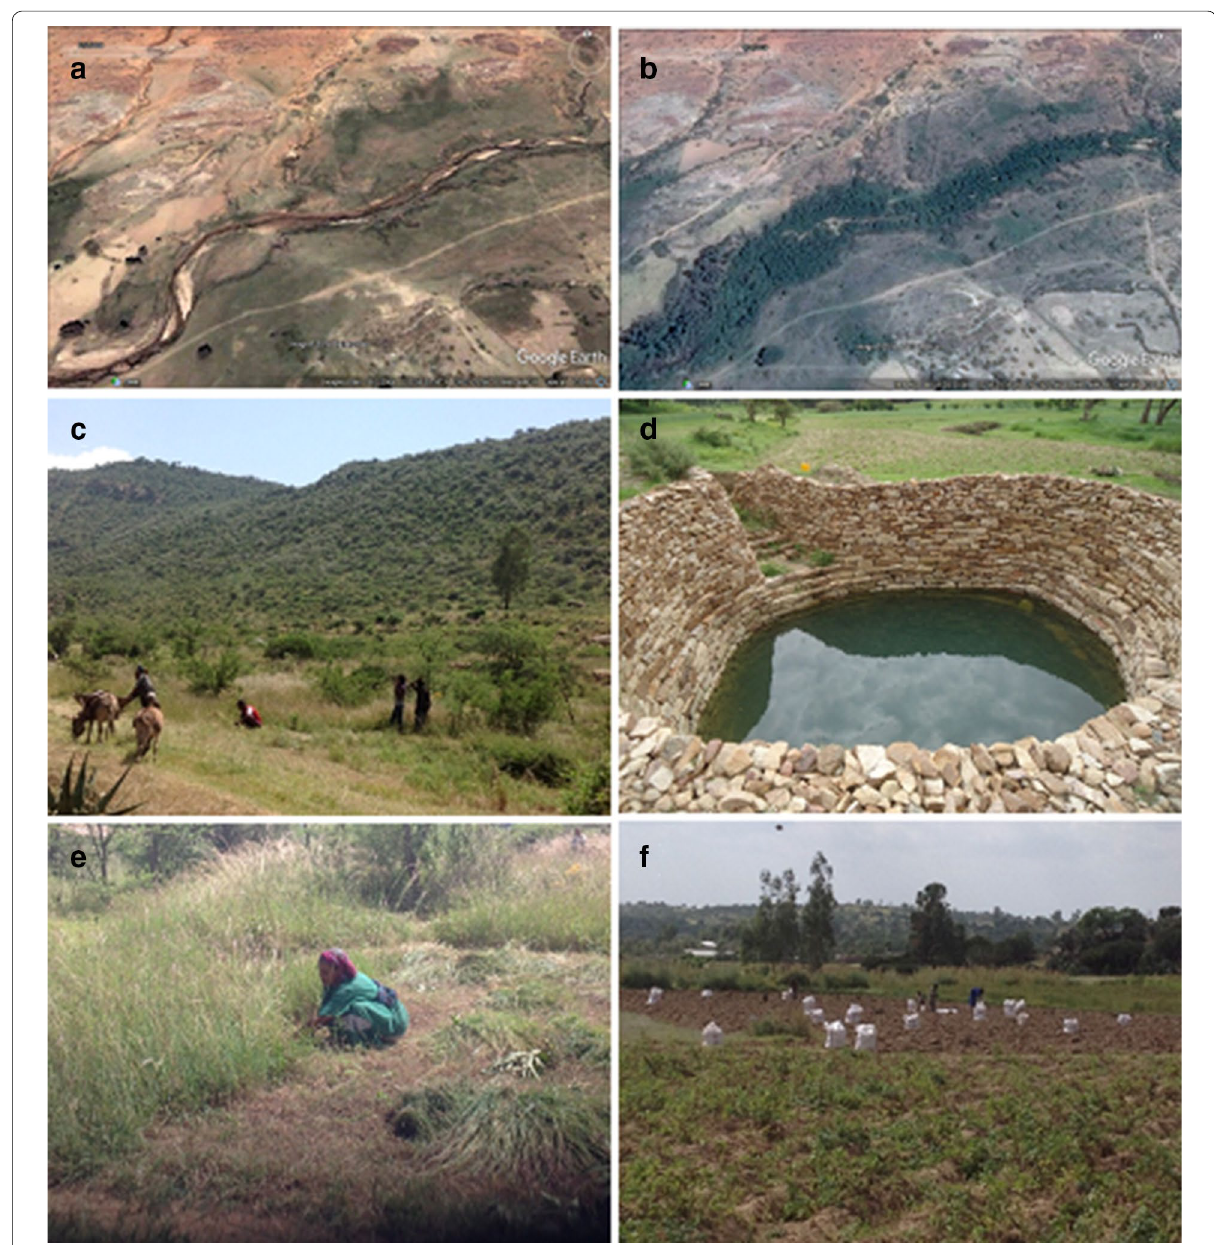
Fig. 5 Rehabilitation of degraded landscape and its benefit to local farmers. a Heavy gully observed in 2006 from google Earth (Kilte Awulaelo district, village Abraha Atsibaha); b restored gulley in 2016 photo from google Earth (Kilte Awulaelo district, village Abraha Atsibaha); c conserved hillside (Kilte Awulaelo district, village Abraha Atsibaha, photo: researcher); d ground water harvesting at the bottom of the hill (Hawzen district, Hayelom village, photo: Hawzen district office of agriculture and rural development (HDOARD); e a woman harvesting grass in area exclosure (Kilte Awulaelo district, Abraha Atsibaha, photo: researcher); f potato harvesting from irrigated land (Saesie Tsaeda Emba district, Saz village, photo: